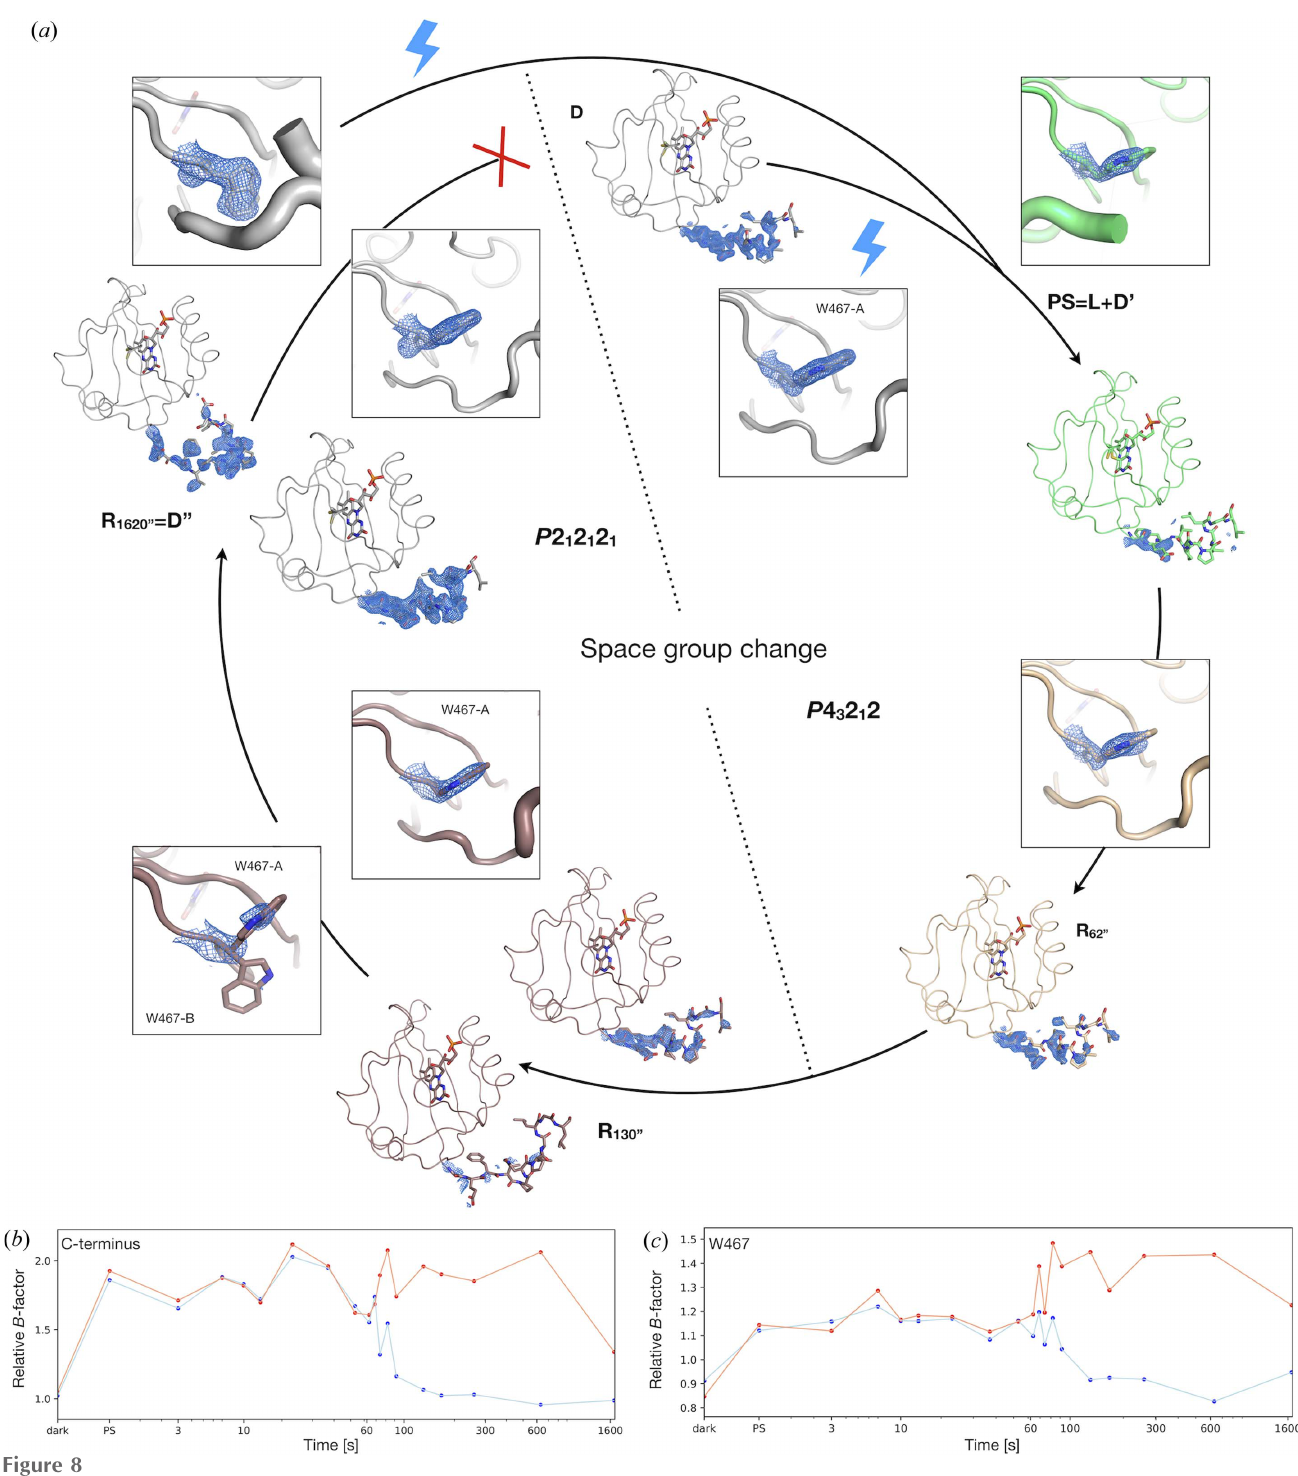
Figure 8 Observation of slow protein dynamics in LOV2 leading to complex C-terminus reordering concomitant with loss of crystal symmetry. ( a ) Structural description of the events occurring to the LOV2 C-terminus along the illumination sequence described in Fig. 1( b ). The 2 F obs (cid:3) F calc electron density map contoured at a 1.5 (cid:4) level is superimposed on the C-terminus (residues 491 to 503) and on residue W467 for the ground state, then at selected time points between the between the PS equilibrium ( t < 0 s) and 1620 s. The C-terminus is ordered in the D-state, disorders in the PS equilibrium, then progressively reorders until a crystal phase transition at (cid:5) 70 s, at which point each monomer in the asymmetric unit of the new space group orders dissimilarly. One monomer quickly reorders as in the D-state, the other orders more slowly to a distinct, hook-shaped conformation. The phase transition is governed by a flipping of a conserved tryptophan residue positioned in the vicinity of the C-terminus. The resulting photocycle cannot proceed back to the D-state (red cross), but can be reset by re-illumination. ( b ) Illustration of C-terminus disordering/ordering by monitoring of the normalized B -factor of the stretch of residues 493 to 495 for monomer A ( (cid:2) -helical C-terminus) in orange, and for monomer B (hook-shaped C- terminus) in blue. ( c ) Corresponding evolution of the normalized B -factor of W467, suggesting a rationale for space group 764 Sylvain Aumonier et al. (cid:4) Slow protein dynamics probed by RT TR-OX IUCrJ (2022). 9 , 756–767